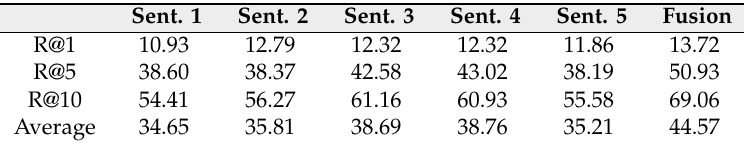
Table 2. Bidirectional text image matching results on our dataset by using ResNet50. Sent. 1 Sent. 2 Sent. 3 Sent. 4 Sent. 5 Fusion